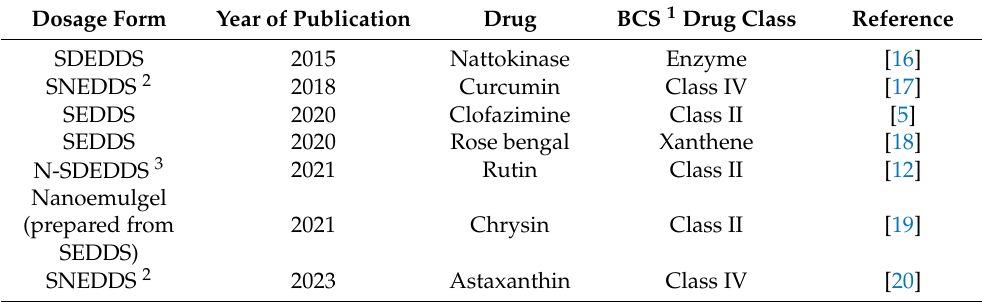
Table 1. Recent developments published on dermal spontaneous